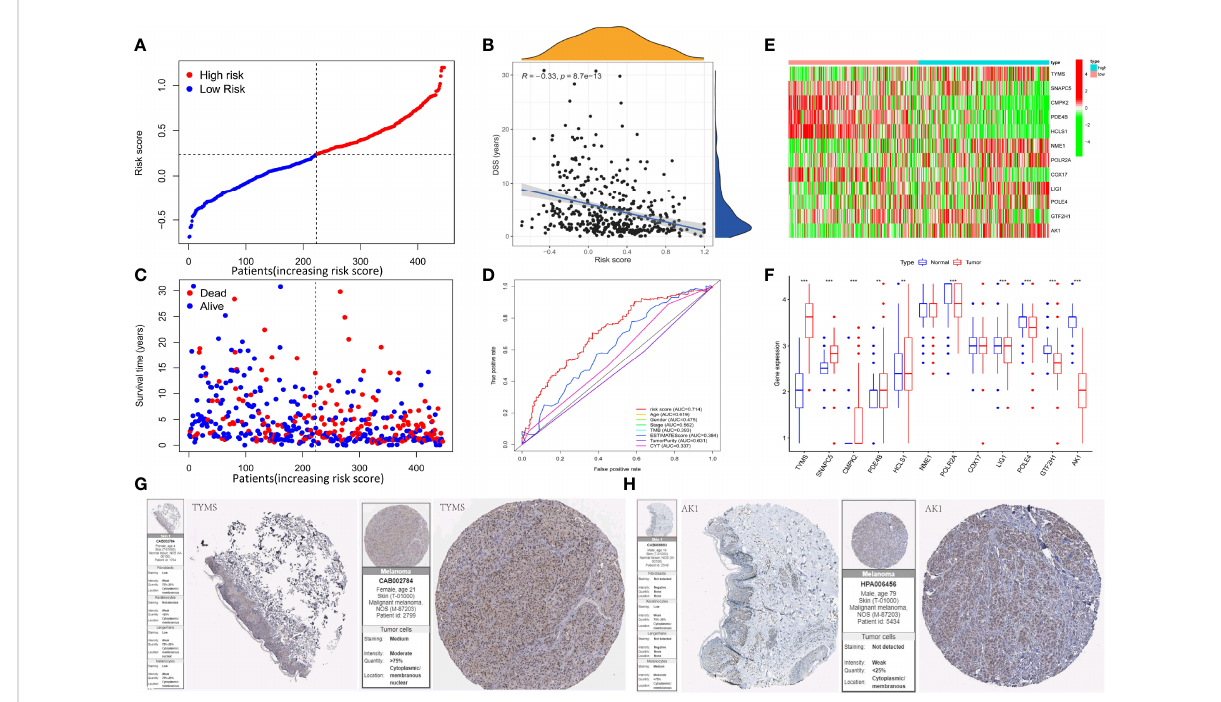
FIGURE 3 Construction of the DRRGs signature and prognostic analysis. (A) Risk score distribution among patients with SKCM; (B) Spearman correlation analysis of risk score and disease-speci fi c survival (DSS); (C) Survival status of each patient with SKCM. Blue signi fi es low risk or alive while red signi fi es high risk or dead; (D) Heatmap of gene expression between the high and low-risk cohort; (E) Relative gene expression between the high and low-risk cohort; (F) AUC values for risk score, age, gender, stage, TMB, ESTIMATE score, tumor purity, and CYT classi fi cation; (G) Immunohistochemical staining images from The Human Protein Atlas of 2 key genes in